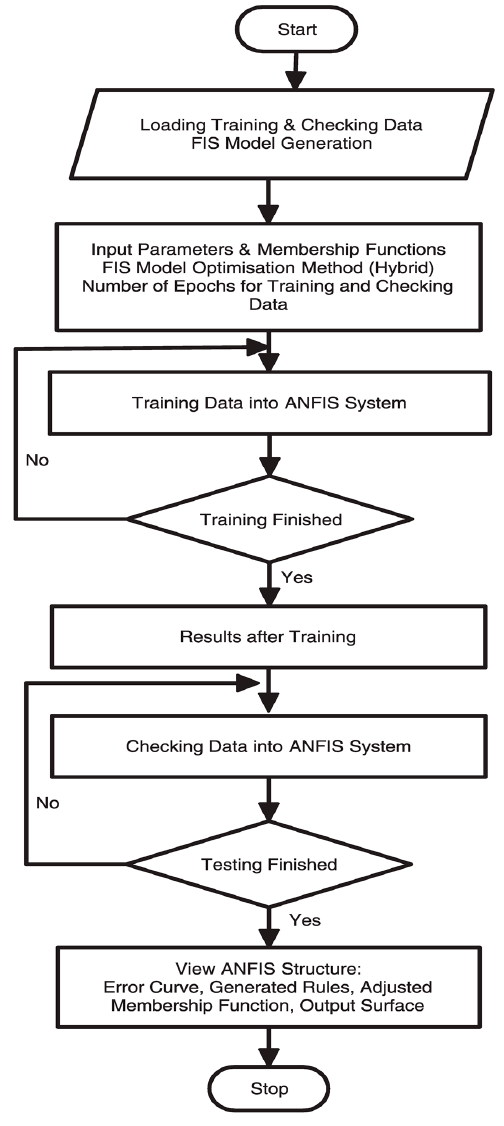
Figure 7. Flowchart of fault detection using the ANFIS system.